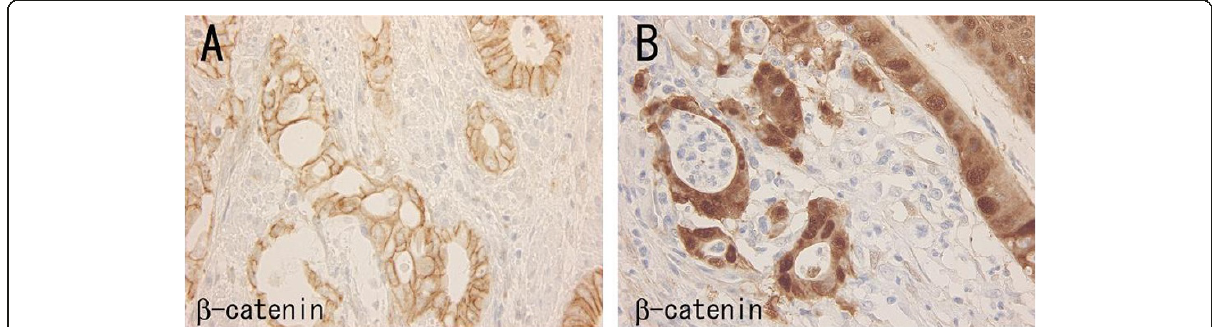
Figure 4 Expression of beta-catenin in a case of ulcerative colitis-associated carcinoma (A) and a case of sporadic colon carcinoma (B) . Strong membranous expression is observed in the UC-associated carcinoma (A). Nuclear and cytoplasmic expression is seen in the sporadic colon carcinoma, instead of membranous expression